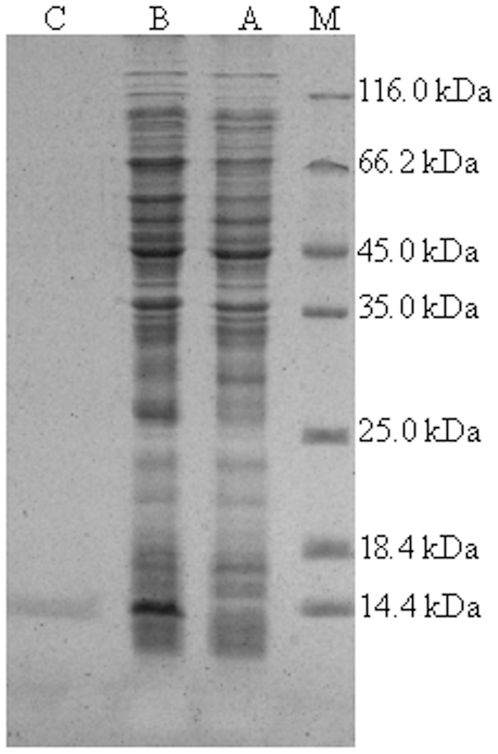
SDS-PAGE analysis of recombinant VpBD.After electrophoresis, the gel was visualized by Coomassie brilliant blue R250 staining. Lane M: protein molecular standard; lane A: negative control for rVpBD (without induction); lane B: induced expression of rVpBD; lane C: purified rVpBD.